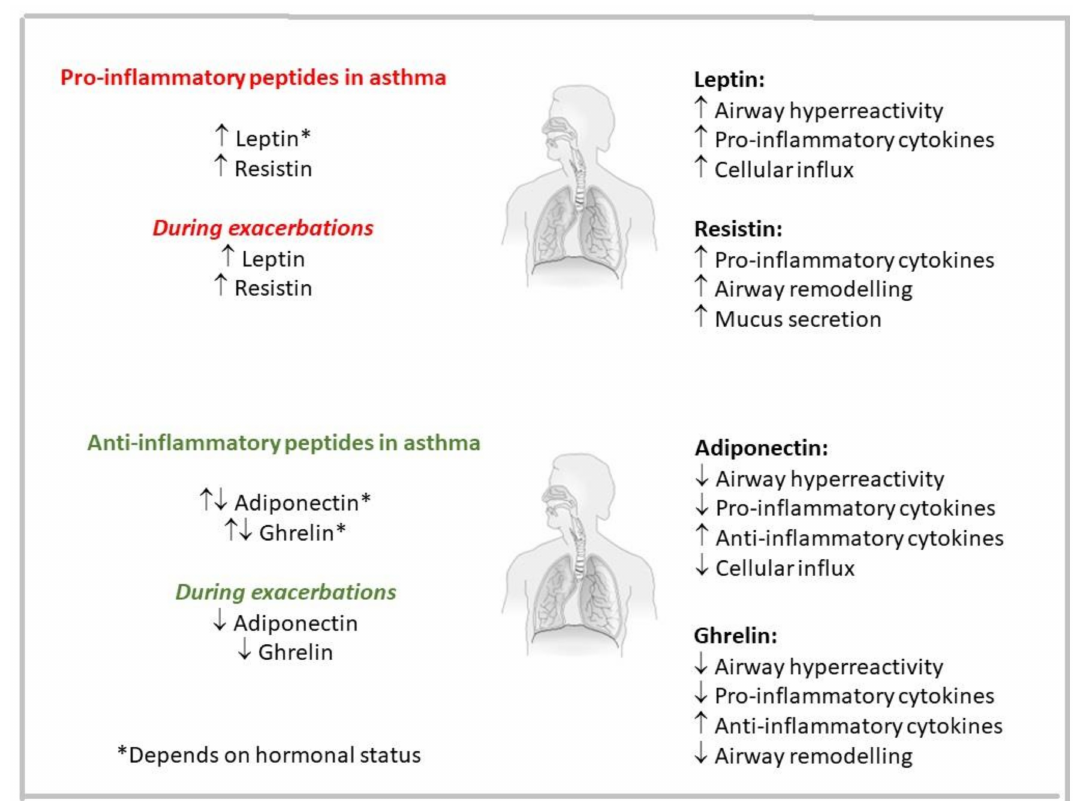
Figure 3. Influence of pro- and anti-inflammatory obesity-related peptides on the main features of asthma. One must keep in mind that it is not the concentration of the respective peptide alone that counts but also the ratios between them [135]. * is present in the figure